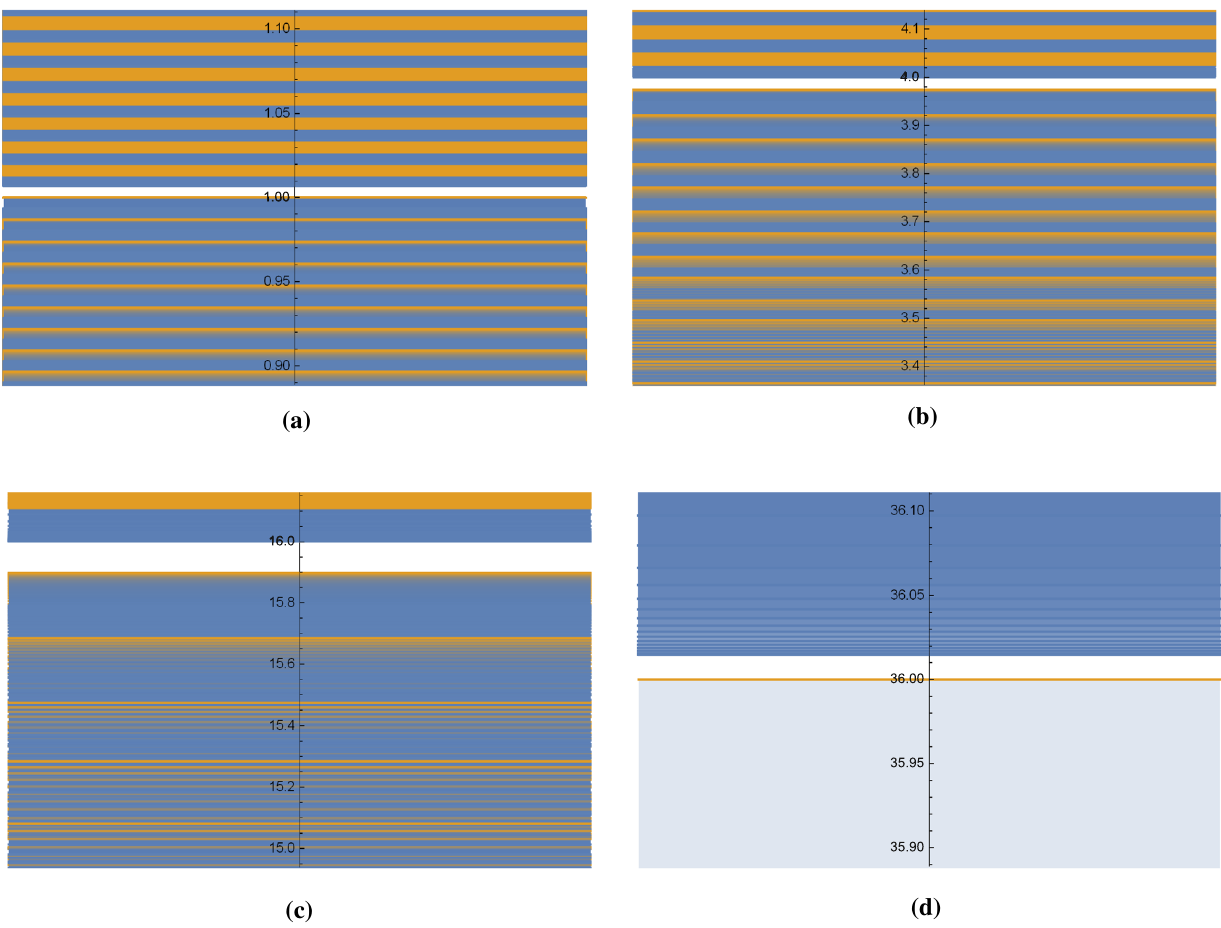
Fig. 9 Covering region of bounds for n = 1–150, l =1–150, four gaps at 1, 4, 16, 36 are still visible. There are upper bounds locating right at H = 1 , 36 but the points H = 1 , 36 are not covered by the open